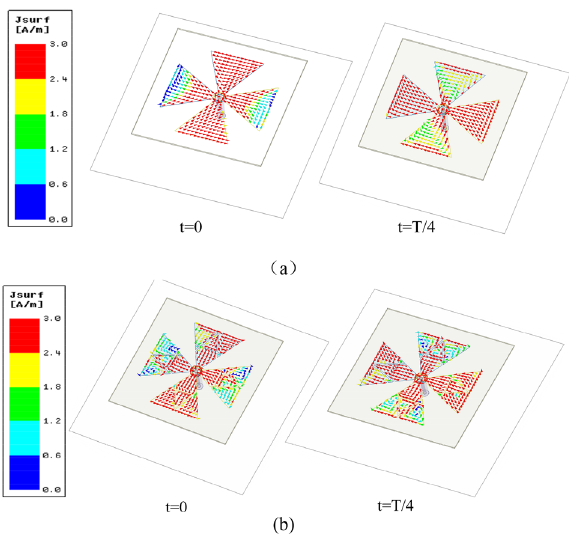
Figure 3. Current distribution on the crossed dipole of reference antennas. ( a ) Reference antenna I, ( b ) reference antenna